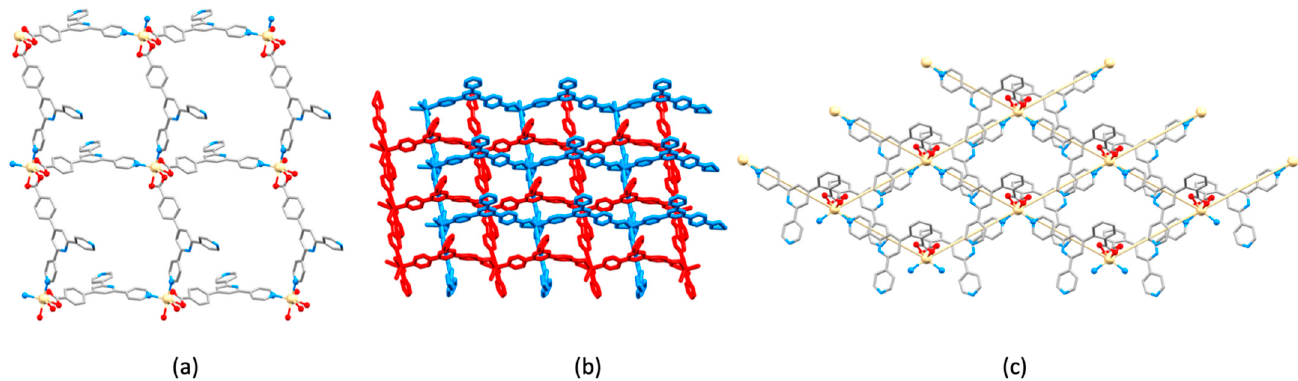
Figure 33. ( a ) Part of one 2D-sheet in [Cd 2 ( 17 ) 4 ] n · 3.5 n H 2 O (CSD refcode JUHYUI), and ( b ) 2D → 2D parallel interpenetration Figure 33. (a) Part of one 2D ‐ sheet in [Cd 2 ( 17 ) 4 ] n . 3.5 n H 2 O (CSD refcode JUHYUI), and (b) 2D  2D parallel interpenetration of the nets in this assembly. (c) Part of the 2D ‐ net in [Cd 2 ( 34 ) 4 ] n . n H 2 O with rhombuses highlighted (refcode FIZWES). of the nets in this assembly. ( c ) Part of the 2D-net in [Cd 2 ( 34 ) 4 ] n · n H 2 O with rhombuses highlighted (refcode